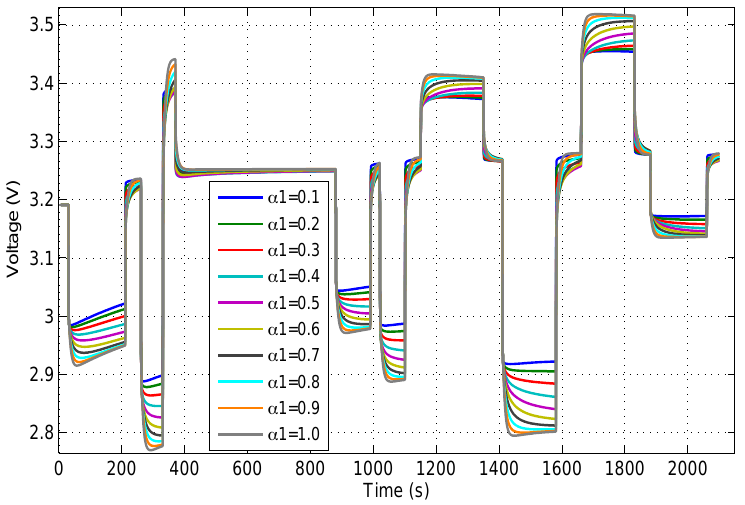
Figure 18. Differences of fractional-order model output voltage by changing value of α 1